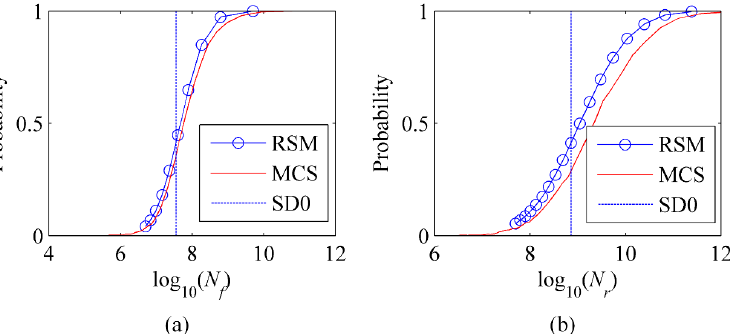
Figure 11. Results of the cumulative probability distributions of the allowed number of load repetitions for ( a ) fatigue failure and ( b ) rutting (SD0 = result for the random variables when standard deviations equal zero).